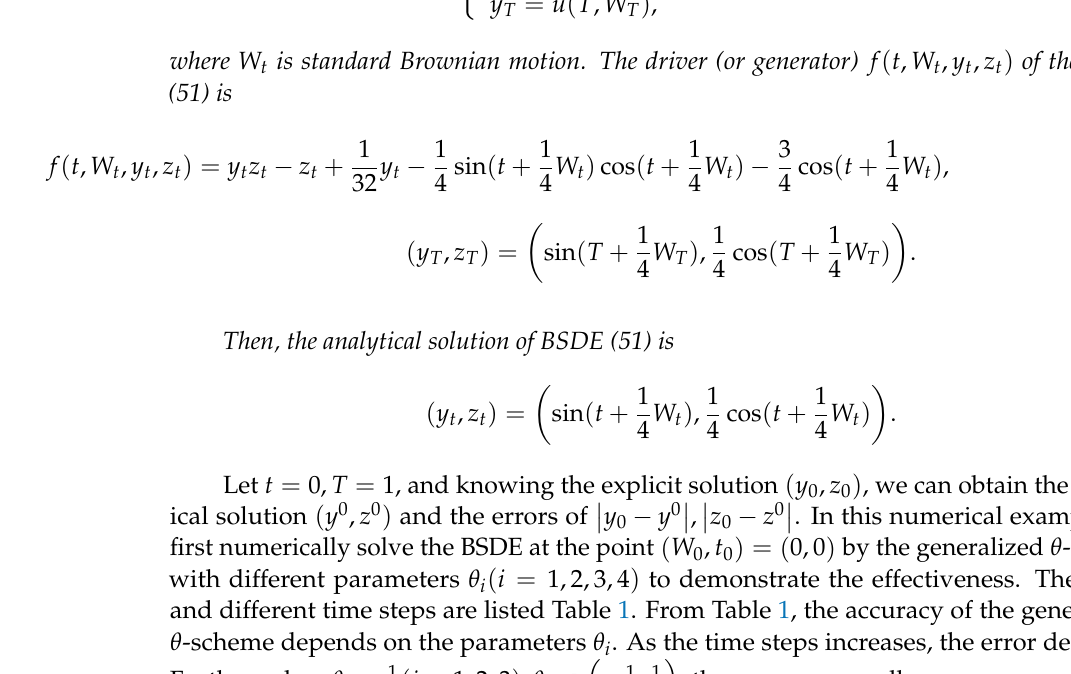
Table 1. The errors Scheme A Scheme B Scheme C